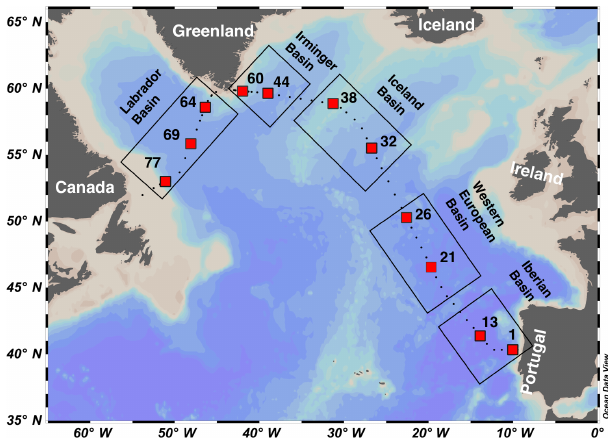
Figure 1. Map of stations occupied during the GA01 transect in the North Atlantic. The red squares indicate the stations where 210 Po and 210 Pb activities were measured, as discussed in this study. The transect is divided into the Iberian Basin (stations 1, 13), the West- ern European Basin (stations 21, 26), the Iceland Basin (stations 32, 38), the Irminger Basin (stations 44, 60), and the Labrador Basin (stations 64, 69,